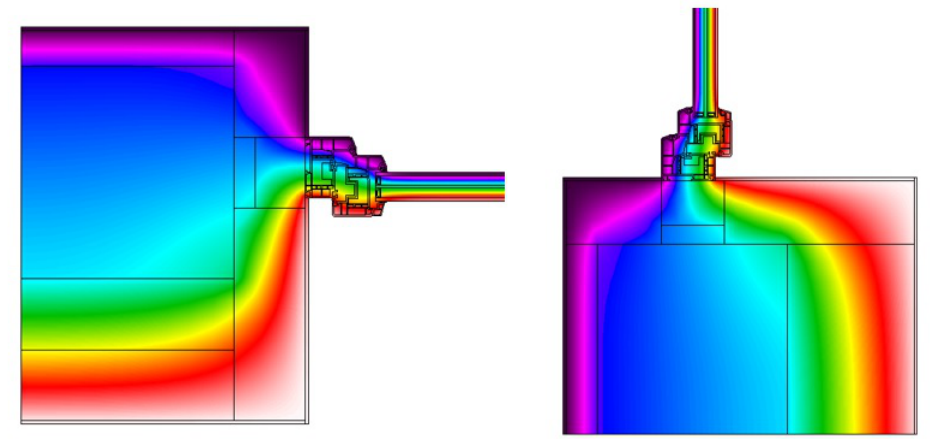
Figure 7. Temperature waveforms according to the Therm software simulation at the lining and sill